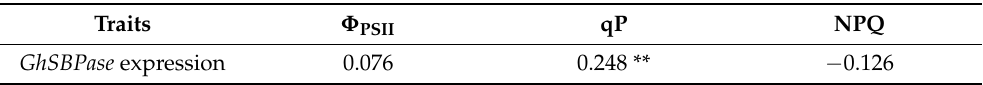
Table 1. Correlation coefficients among GhSBPase expression and chlorophyll fluorescence parameters in a natural population. Traits Φ PSII qP NPQ GhSBPase expression 0.076 0.248 ** −